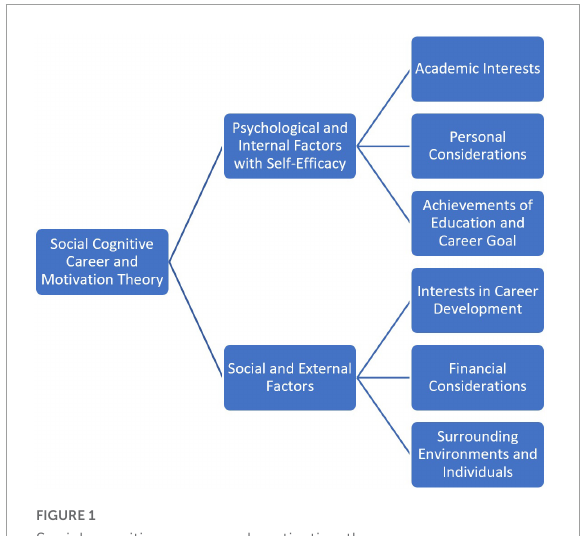
FIGURE1 Social cognitive career and motivation